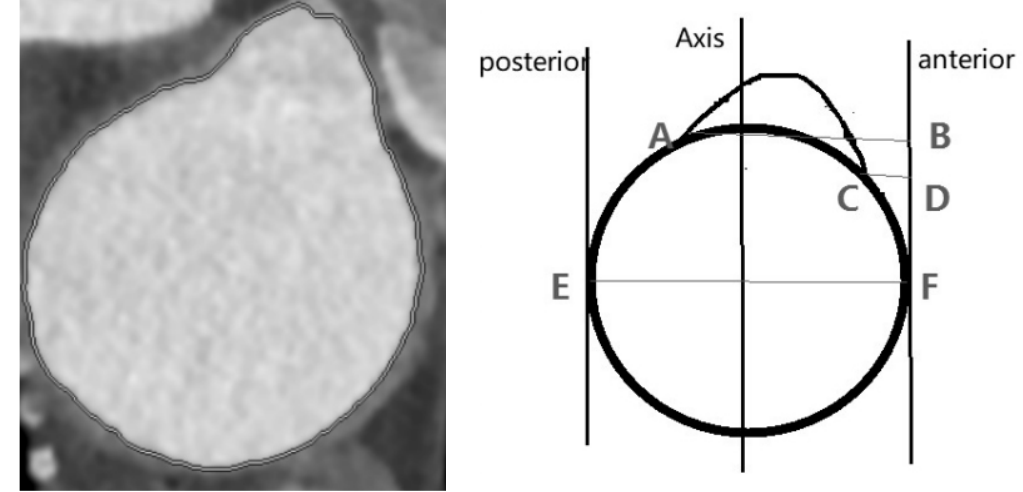
Fig. 3 - Actual three-branch cross-section diagram and schematic diagram. The intersection (A,C) of the branch opening and the aortic arch were marked on the cross-sectional image. Cross-sectional diameter was determined by EF. The line passing BD was drawn perpendicularly to EF, and the line AB, CD was parallel to EF.